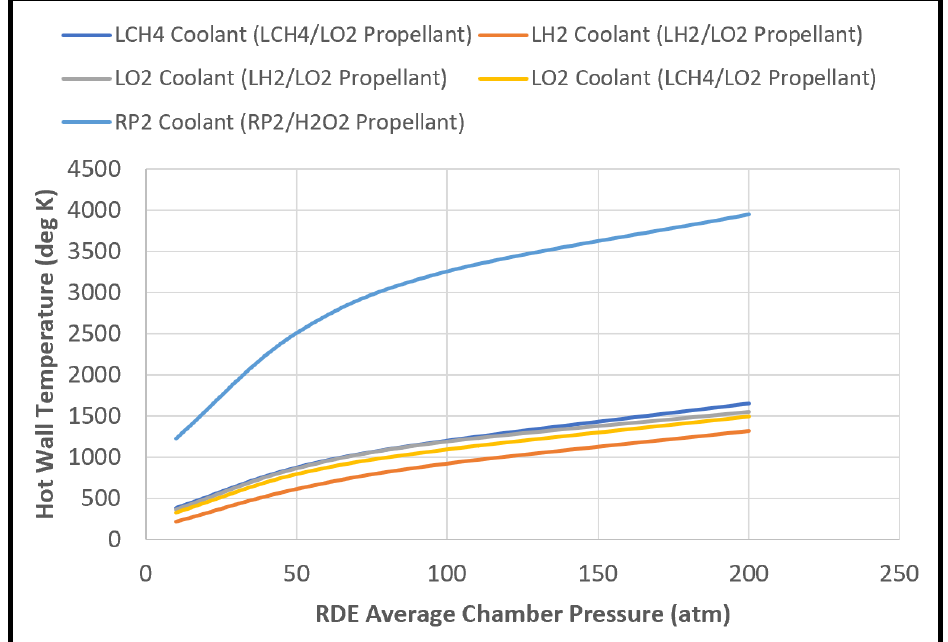
Figure 9. Predicted RDE Hot Wall Temperature for Multiple Chamber Pressures and Propellant Combinations.